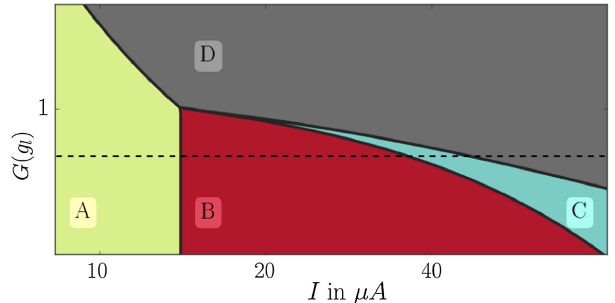
FIG. 3. Phase diagram with phase A for no selected mode, phase B when mode h is selected, phase C when both modes are selected, and phase D when mode l is selected. Plotted versus the injection current I that is proportional to pump rate P and the ratio l l l =g = l of the effective-gain rates G ¼ g with fixed g . l h h l h l h Except for g , all parameters are the same as in Fig. 2. The dashed l line indicates the value of g used in Fig. 2. While for G < 1 all l phases are present when increasing the pump rate P , for G > 1 the mode l , which is favored by the direct mode coupling, actually becomes the high-effective-gain mode; thus, no mode switching